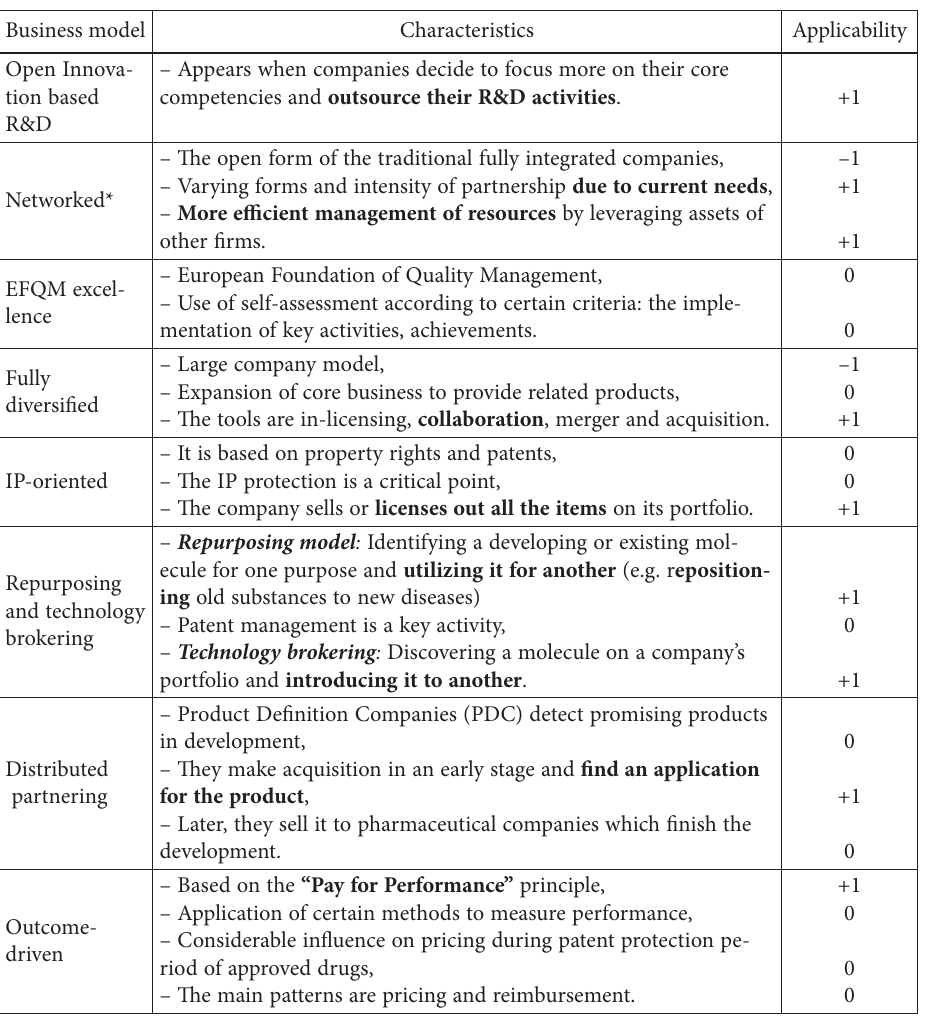
Table 3. Regular open business models of the Belgian pharmaceutical biotech industry (source: self- made based on Segers, 2017) Business